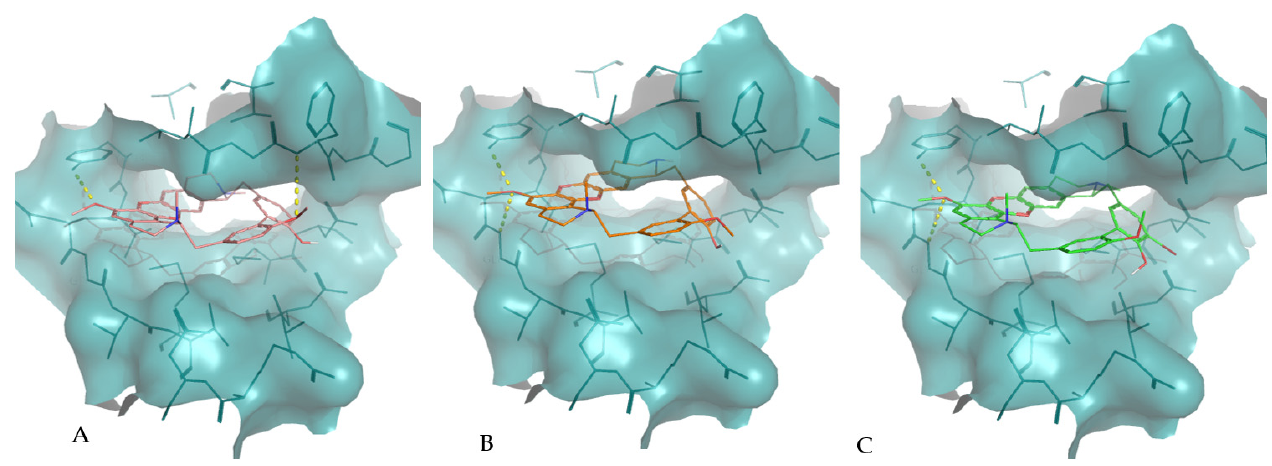
Figure 3. Molecular interactions of the best docking positions of tiliacorine ( A ), nortiliacorinine ( B ) and 13 ′ -bromotiliacorine ( C ) against PknB. Hydrogen bonds are shown as yellow dashed lines.